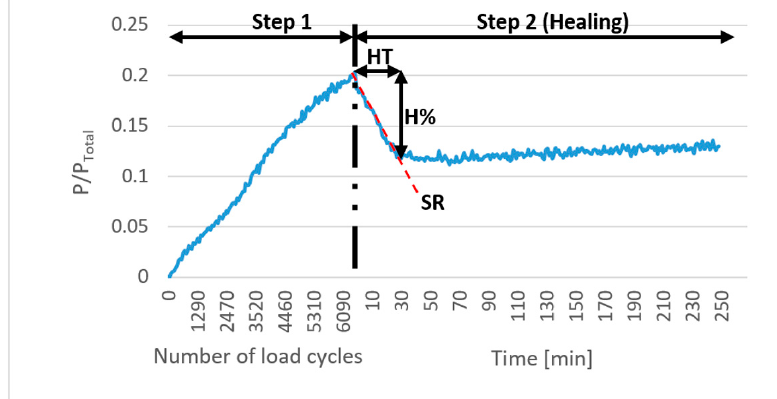
Figure 4. Number of the facets with horizontal strain higher than 10 µE (P) over the total number of facets (P total ) including the definition of healing time (HT), percentage of the strain recovery (H%), and strain recovery speed (SR).